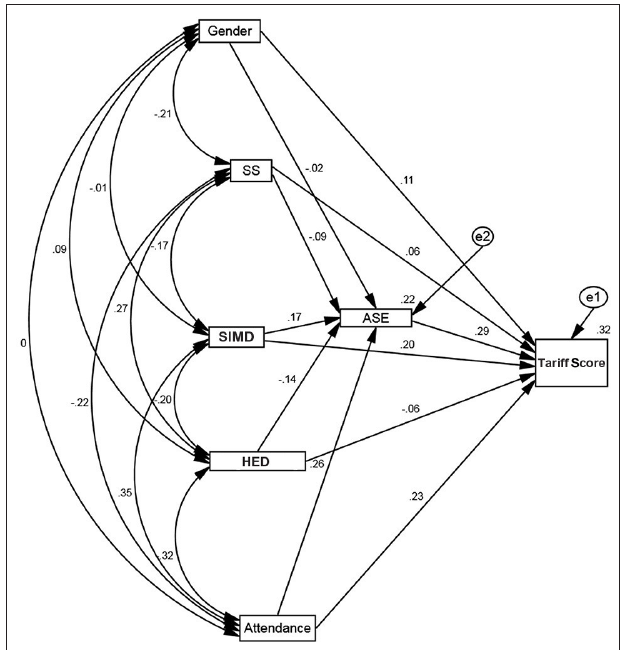
FIGURE 4 | Path analysis including SS, attendance, HED, and gender as additional effects.